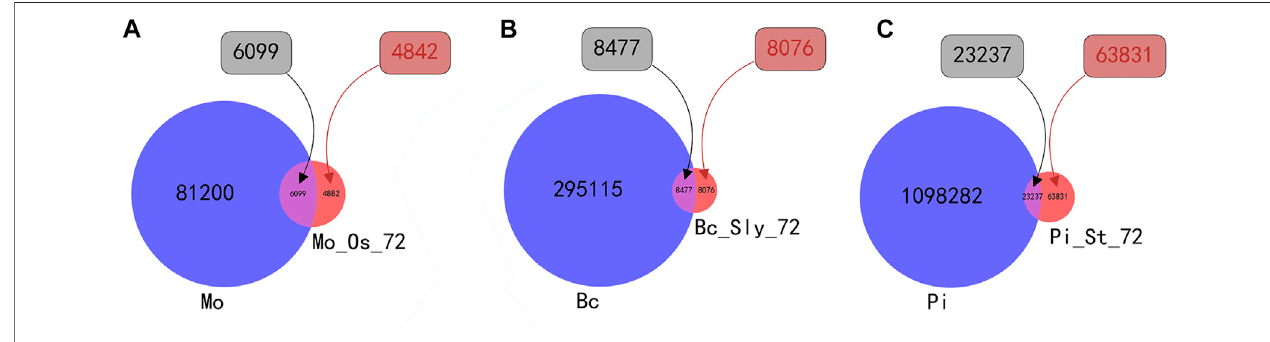
FIGURE4| VenndiagramofthenumberofsRNAtypesbeforeandafterinfection. Mo istheabbreviationforthenumberof Magnaportheoryzae sRNAspecies,and MO_Os_72 is the abbreviation for the number of Magnaporthe oryzae sRNA species after Magnaporthe oryzae infecting Oryza sativa for 72 h. Bc is the abbreviation